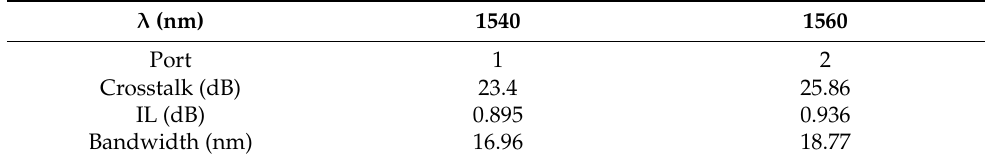
Figure 7. Normalized power as a function of wavelength over the C-band range.